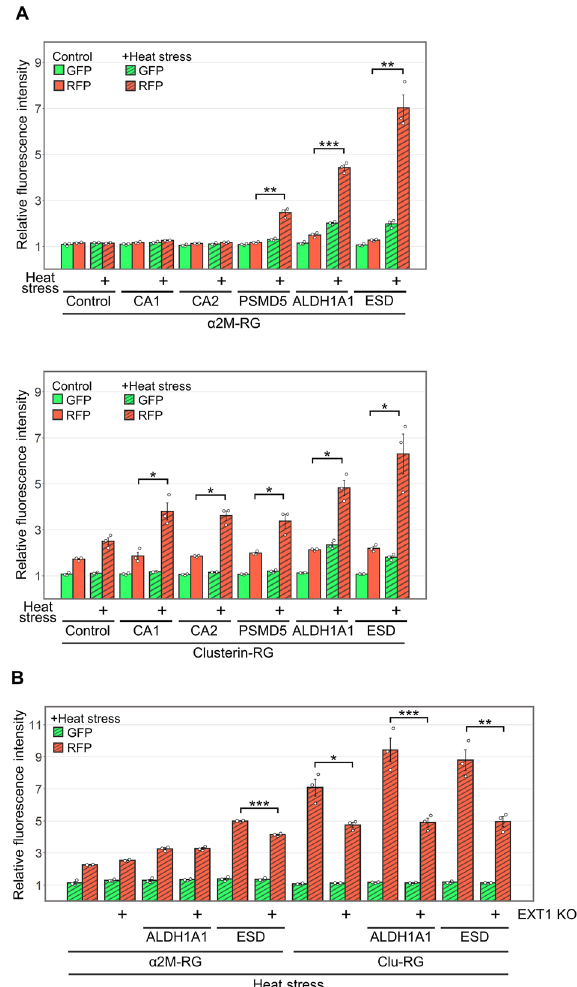
Figure 5. Degradation activity of α 2 M differed from degradation activity of clusterin. ( A ) α 2 M–RG and Clu-RG internalization assays. Substrates (CA1, CA2, PSMD5, ALDH1A1, and ESD) were each mixed with α 2 M–RG or Clu-RG; mixtures were heat-shocked in serum-free medium at 50 °C for 1 h. HeLa cells were cultured in medium for 17 h at 37 °C, then analyzed using flow cytometry. ( B ) α 2 M–RG and Clu-RG internalization assays with EXT1 KO cells. Substrates (ALDH1A1 and ESD) were each mixed with α 2 M–RG or Clu-RG; mixtures were heat-shocked in serum-free medium at 50 °C for 1 h. HeLa WT and EXT1 KO cells were cultured in medium for 17 h at 37 °C, then analyzed using flow cytometry. Bar graph shows the relative fluorescence intensities of GFP and RFP in cells normalized to those intensities in untreated cells (n = 3). Data are means ± SEMs. * P < 0.05; ** P < 0.01; *** P < 0.005 (two-tailed Student’s t -test). Small circles indicate each data